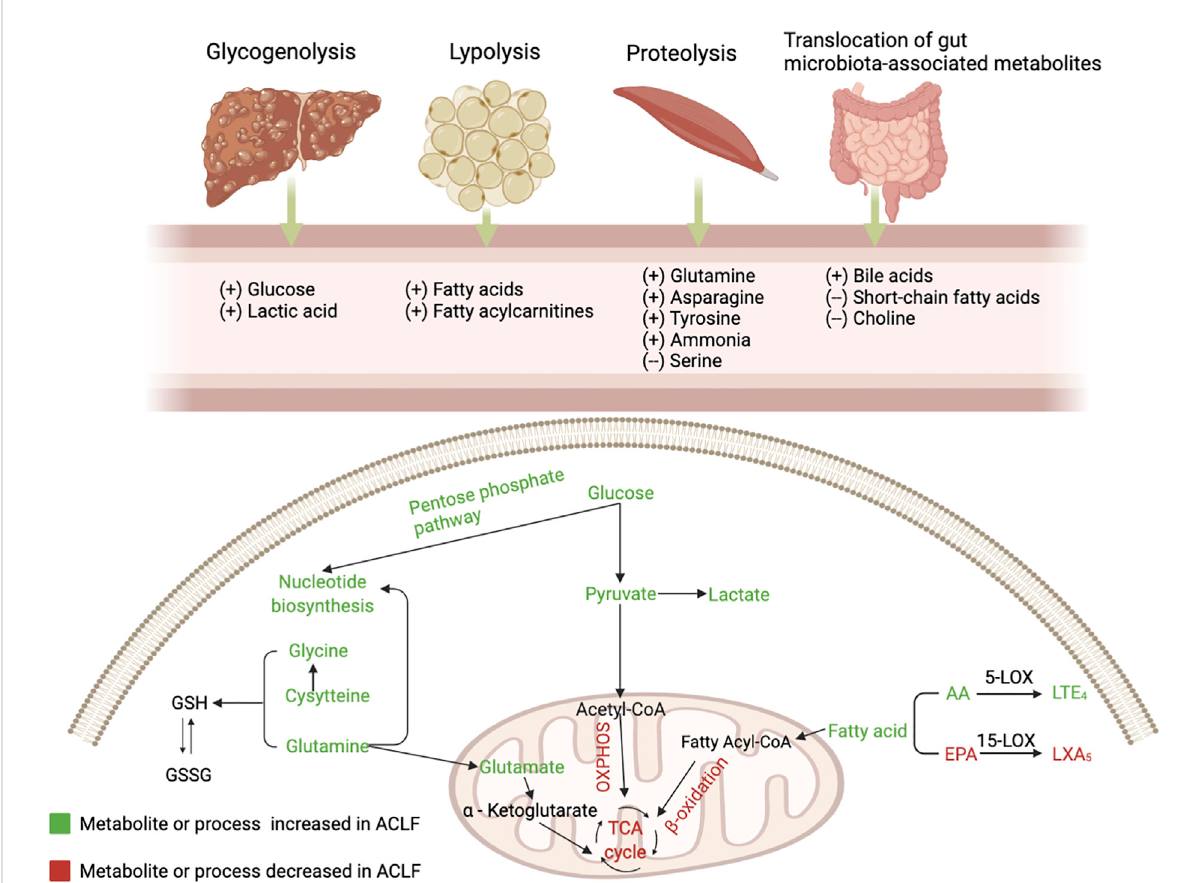
The alterations of serum metabolites and key metabolic pathways in acute-on-chronic liver failure (ACLF). Glycogenolysis (liver), proteolysis (mainly muscles), lipolysis (adipose tissue), and bacterial translocation (gut) are induced in the context of ACLF, resulting in the release of glucose, amino acids, fatty acids and gut microbiota-associated metabolites. During PAMP-induced systemic in fl ammation, glucose is used for promptly producing ATP through glycolysis and enters the pentose phosphate pathway that is involved in nucleotide synthesis, while mitochondrial oxidative phosphorylation (OXPHOS) is suppressed; Mitochondrial β -oxidation of FAs is inhibited and blood level of fatty acylcarnitines is increased; Increased generationand accumulation of manyblood amino acid metabolites areinvolvedinvarious amino acid metabolism. AA,